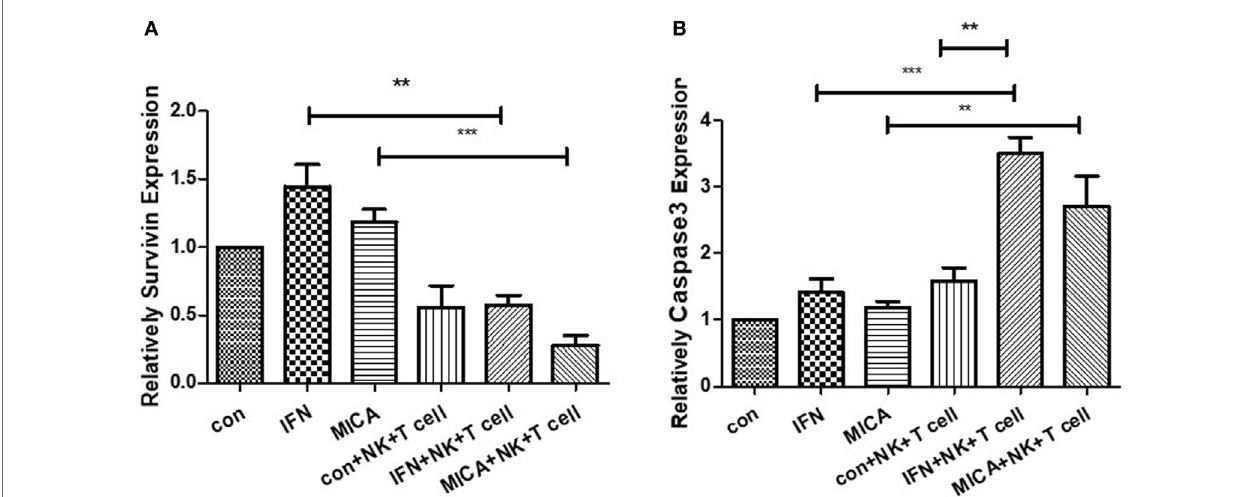
FigUre 9 | Survivin expression (a) decreased and Caspase3 expression (B) increased with MICA overexpression. RT-qPCR measured the Survivin and Caspase 3 mRNA expression levels after pcDNA3.1-GFP-MICA transfection or IFN- γ treatment. ** p < 0.01; *** p <